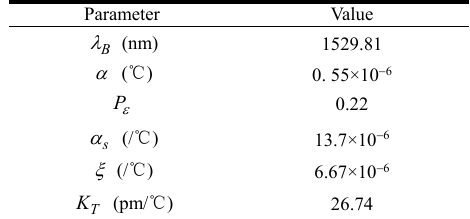
Table 1 Parameters for the temperature sensitivity (2) for the FGB.